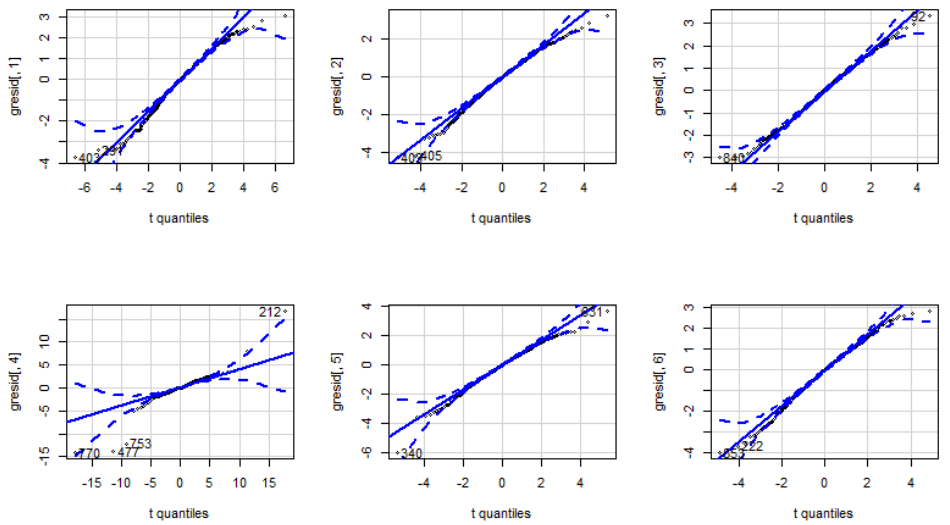
Figure 3. The Student’s t-quantile functions of the residuals of GARCH(1,1) for each